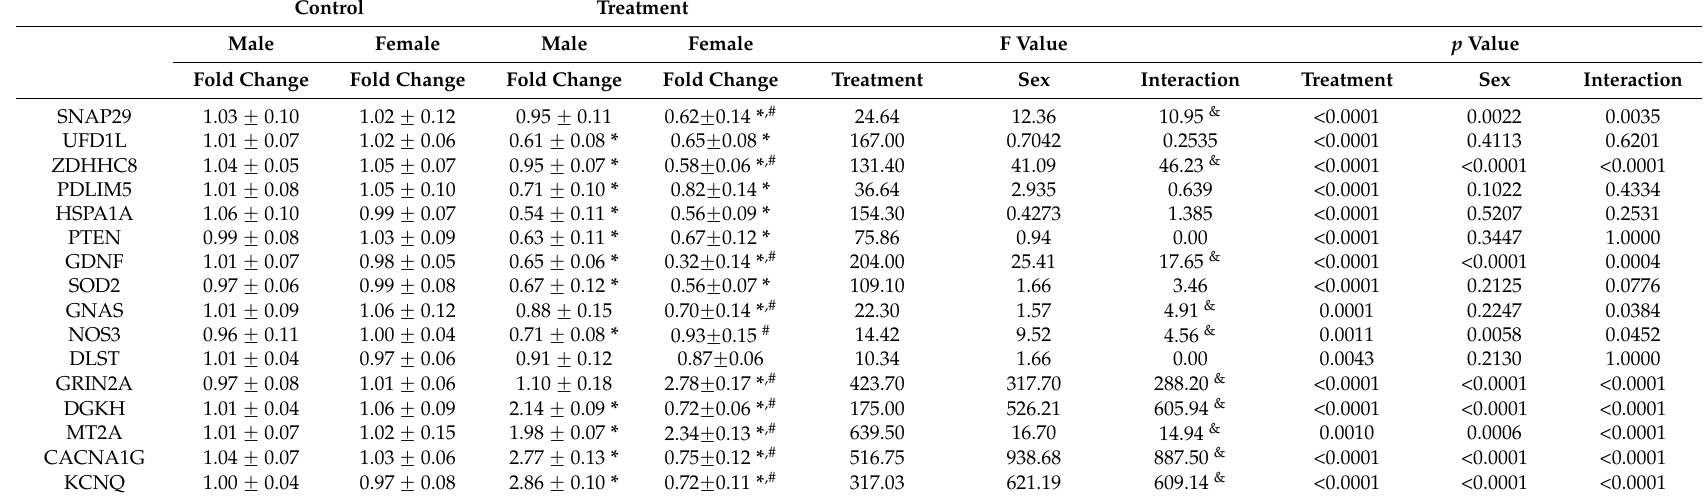
Table 2. Fold induction of modulated genes in mice